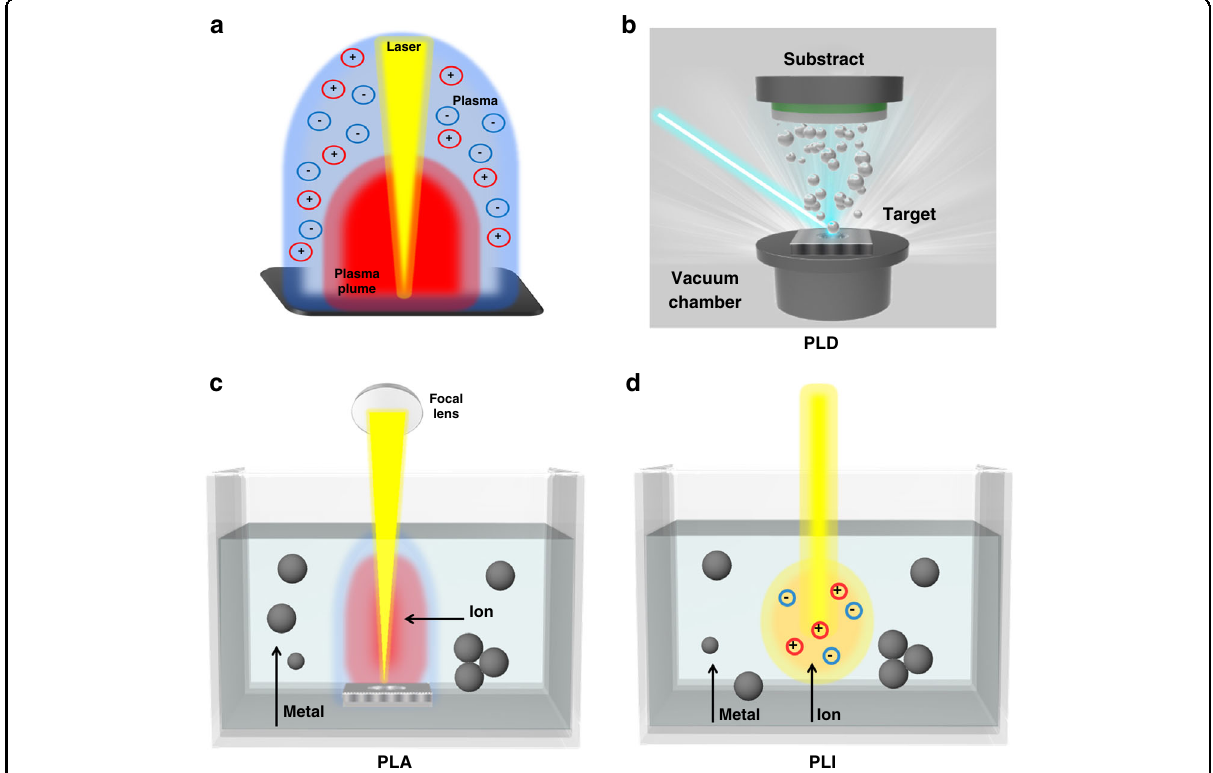
Fig. 2 Schematic illustration of pulsed laser methods. a laser-induced plasma plume, b PLD, c PLAL, and d